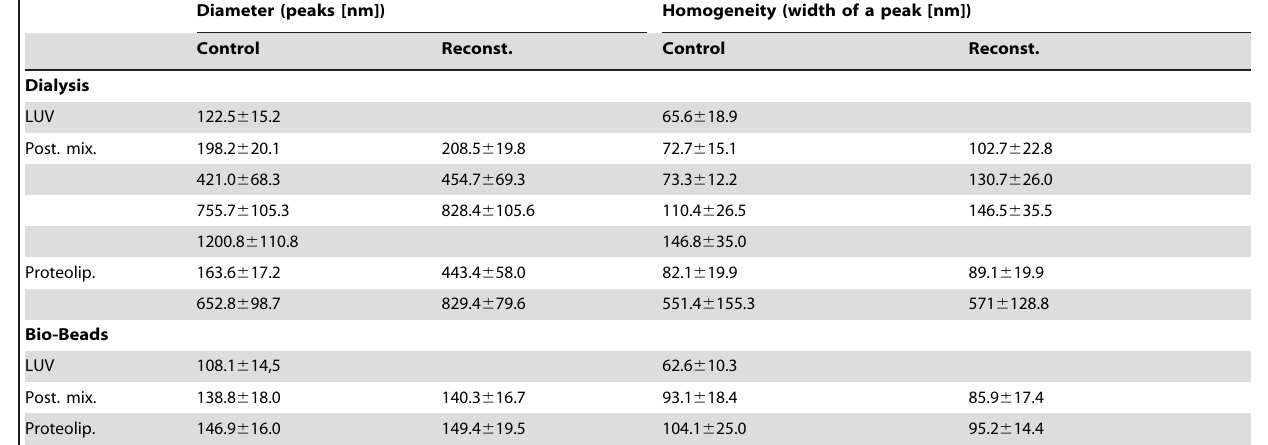
Table 3. Reconstitution of protein using DM.